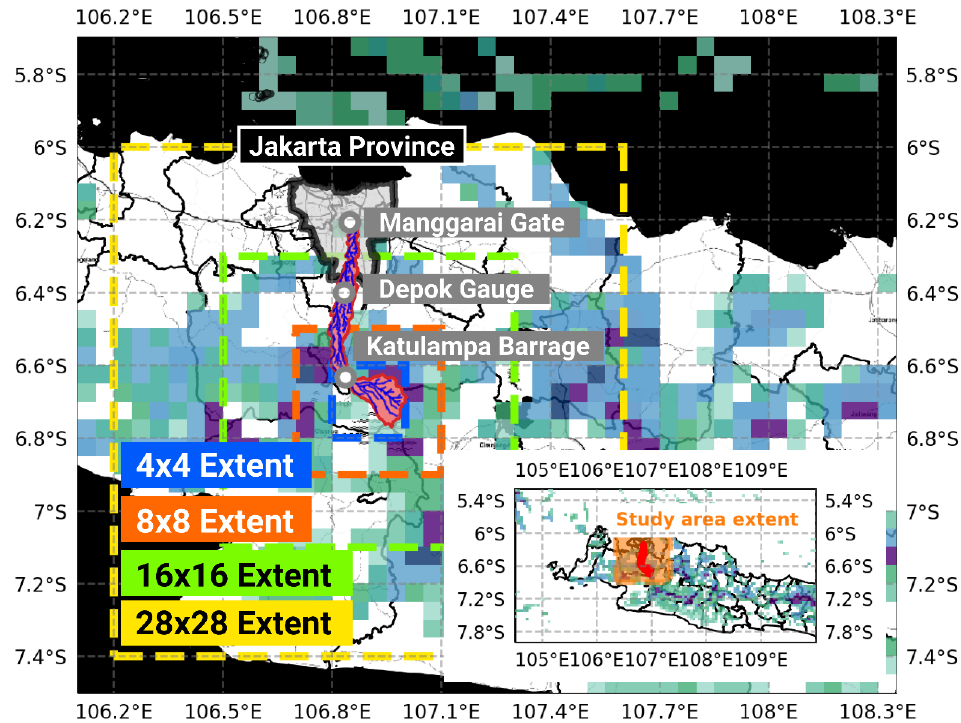
Figure 3. Sadewa data processing extents. The colors of the dashed box boundaries represent different boundary extents.